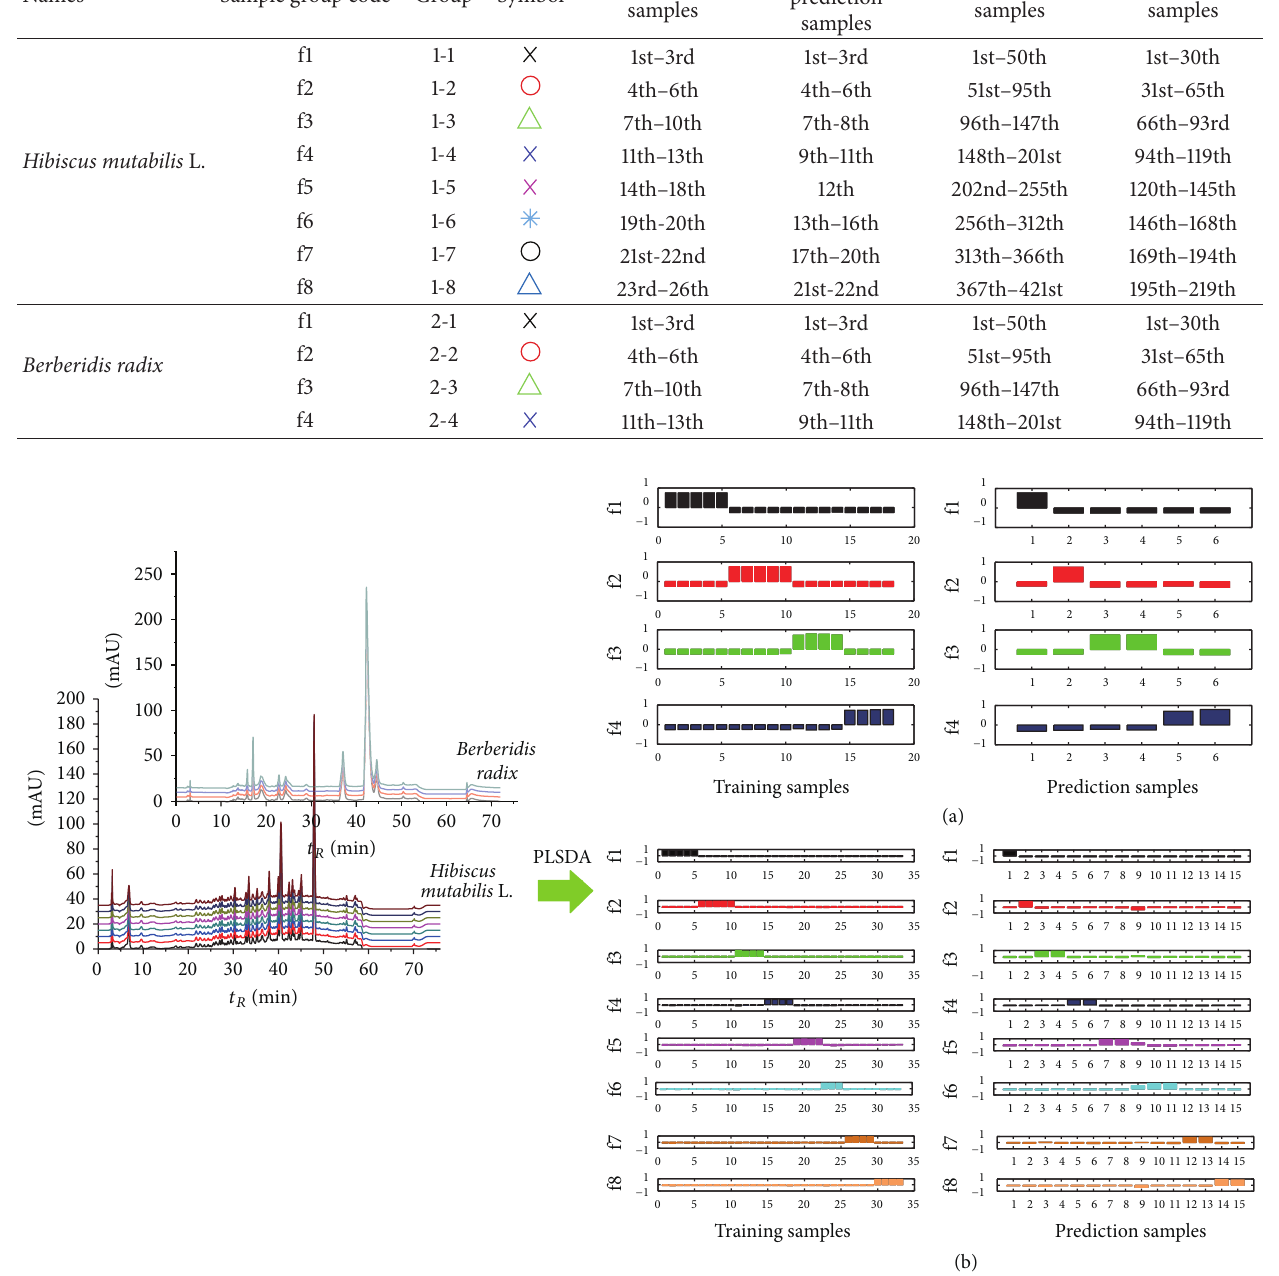
Figure 2: Assigned plots of dummy codes of the training set and prediction set for raw HPLC chromatogram of Hibiscus mutabilis L. (a) and Berberidis radix (b) in PLSDA